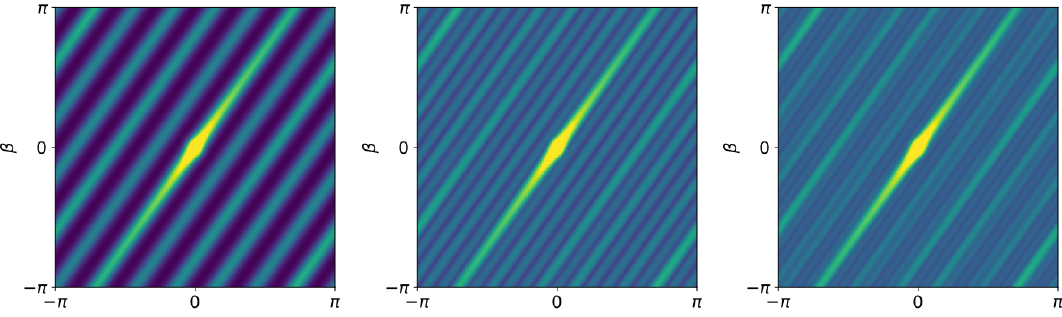
Figure 8: Numerical computations of the norm | K ( x , x (cid:48) ) | given by (18), for points (19) on an edge torus at θ = π/ 2. The color coding is the same as in fig. 7. From left to right, the ratio (7) provides successive continued fraction approximations of namely ∆ = 7 / 5, ∆ = 17 / 12, and ∆ = 41 / 29 (respectively with 129043, 127553 and 127822 particles). Classical trajectories become more and more difficult to dis- tinguish as ∆ converges to an irrational value, motivating the more accurate ‘slice’ plots in fig. 9